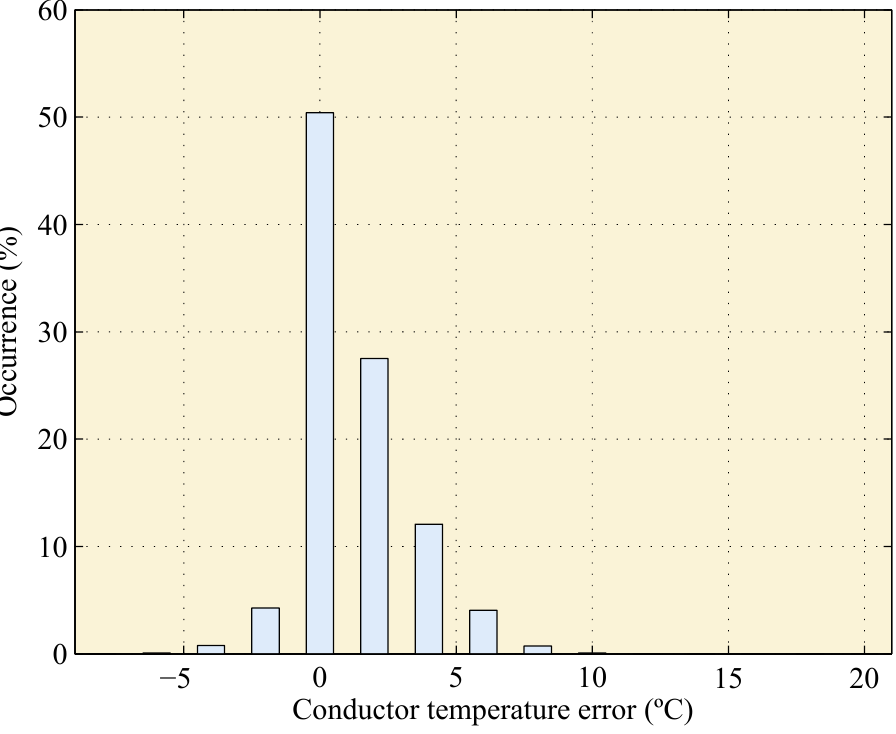
Figure 2. Error in conductor temperature ( T c ) calculation using CIGRE